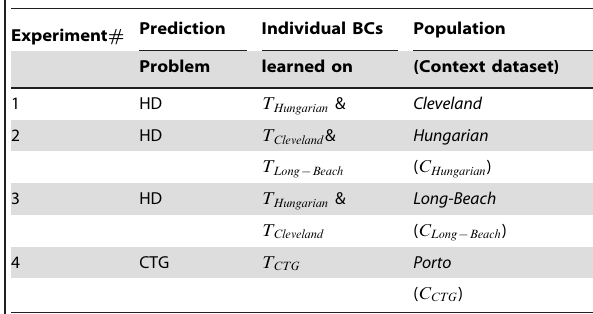
Experiment # Prediction